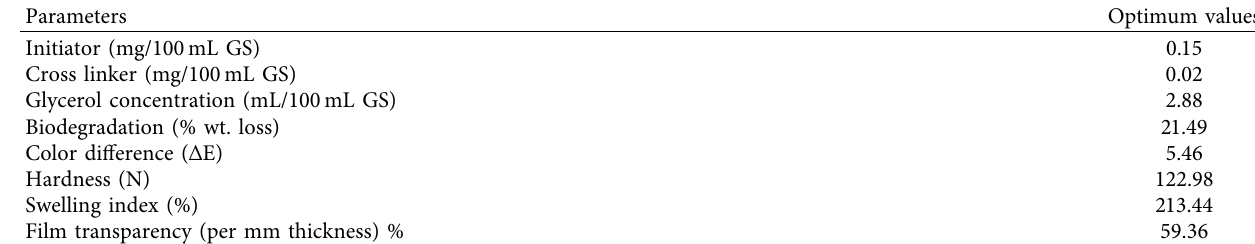
Table 4: Optimum values of developed hydrogel